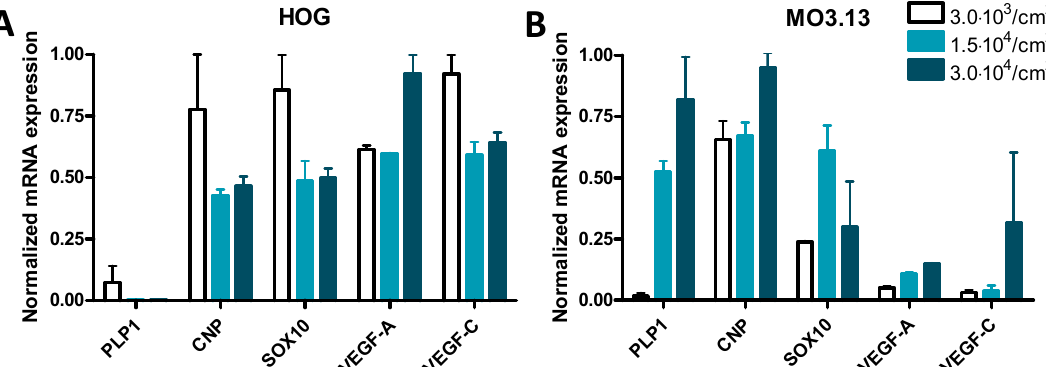
Figure 5. Normalized mRNA expression of PLP1, CNP, SOX10, vascular endothelial growth factor A (VEGF-A) and VEGF-C at various cell densities in ( A ) HOG cells and ( B ) MO3.13 cells. Standard error of the mean (SEM) is based on two technical replicates of one experiment ( n = 1).